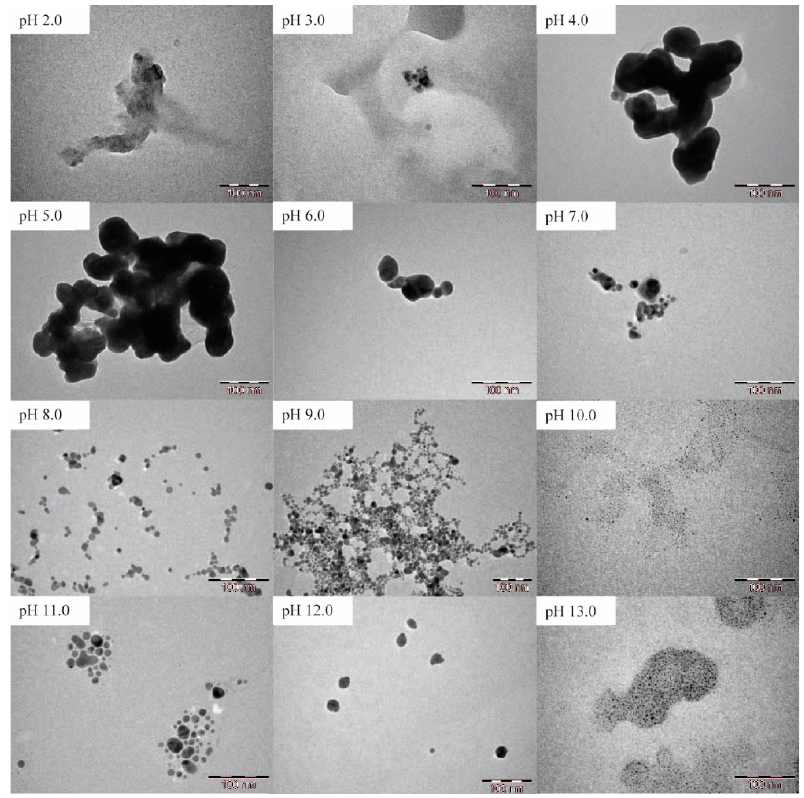
Figure 4. TEM images obtained from dilute solutions of AgNPs synthesized at the pH range 2.0–13.0. All images are scaled to 100 nm.